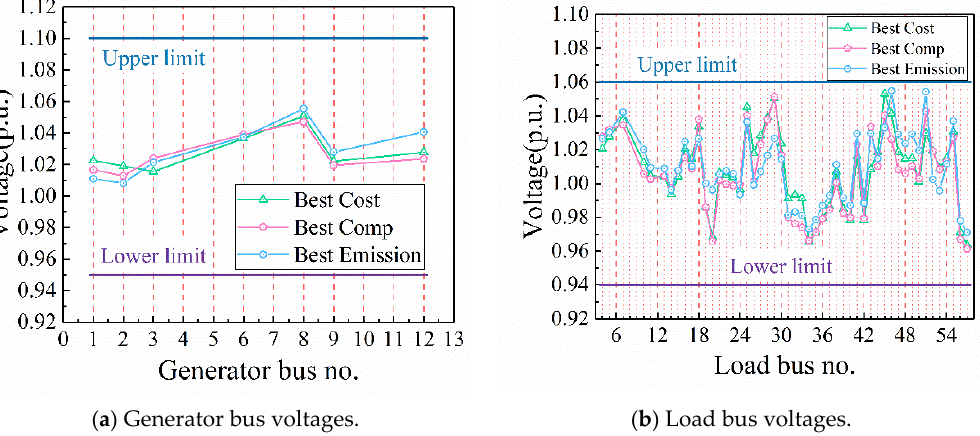
Figure 10. The bus voltages in the three solution scenarios obtained by CMODE for case 2.